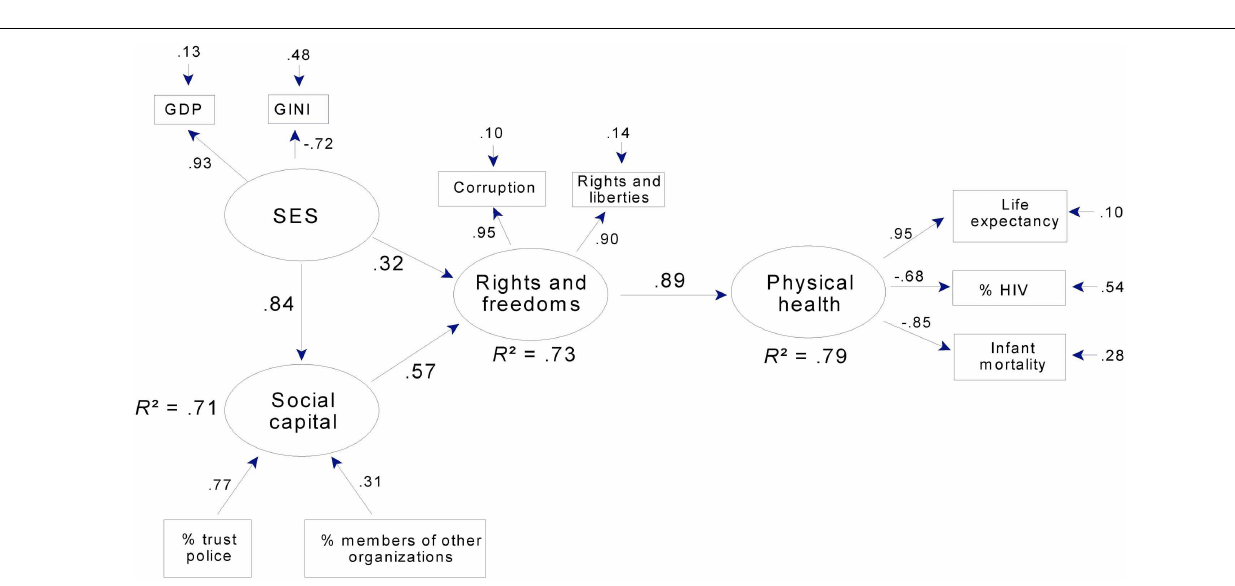
FIGURE 7 | Physical health, social capital, SES, and rights and freedoms: a path model for 23 countries. Note that corruption is reverse-scored, so that high scores = low levels of corruption. Rights and liberties = mean ratings for political rights and civil liberties (see text). Gini: high scores = economic